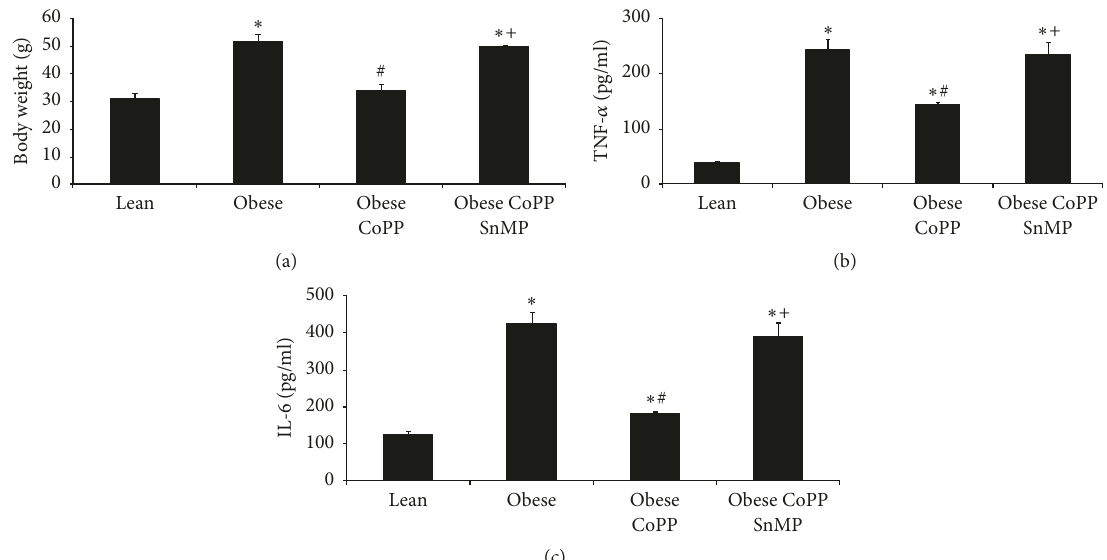
Figure 1: Effect of HO-1 induction on body weight and plasma levels of inflammatory cytokines in lean and obese mice. (a) Effect of CoPP and SnMP coadministration on body weight of obese mice after 6 weeks of treatment. The data are the weights in grams as mean ± SEM ( 𝑝 < 0.05 ). (b) TNF- 𝛼 plasma levels and (c) IL-6 plasma levels results are mean ± SEM 𝑛 = 3-4, ∗ 𝑝 < 0.05 versus lean; # 𝑝 < 0.05 versus obese; + 𝑝 < 0.05 versus obese